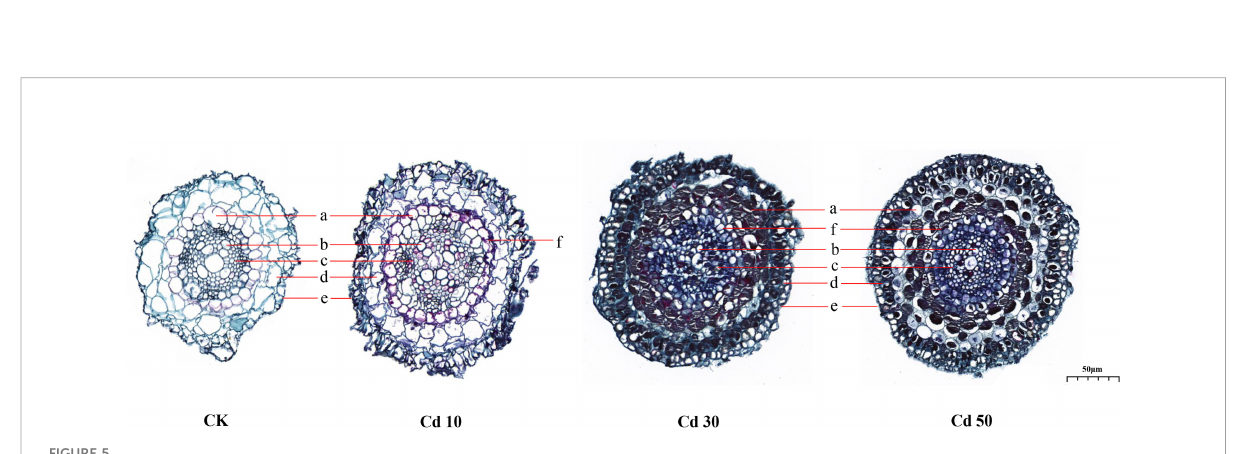
FIGURE 5 The primary structure of roots under different cadmium treatments. a, endodermis; b, primary xylem; c, primary phloem; d, cortex; e, epidermis; f, casparian strip. CK, Cd10, Cd30, Cd50 indicates the Cd concentration 0 mg/L, 10 mg/L, 30 mg/L, and 50 mg/L, respectively.